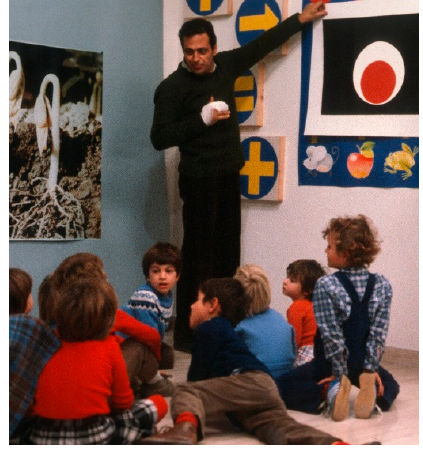
Figure 3. Alberto Manzi, Educare a pensare ,